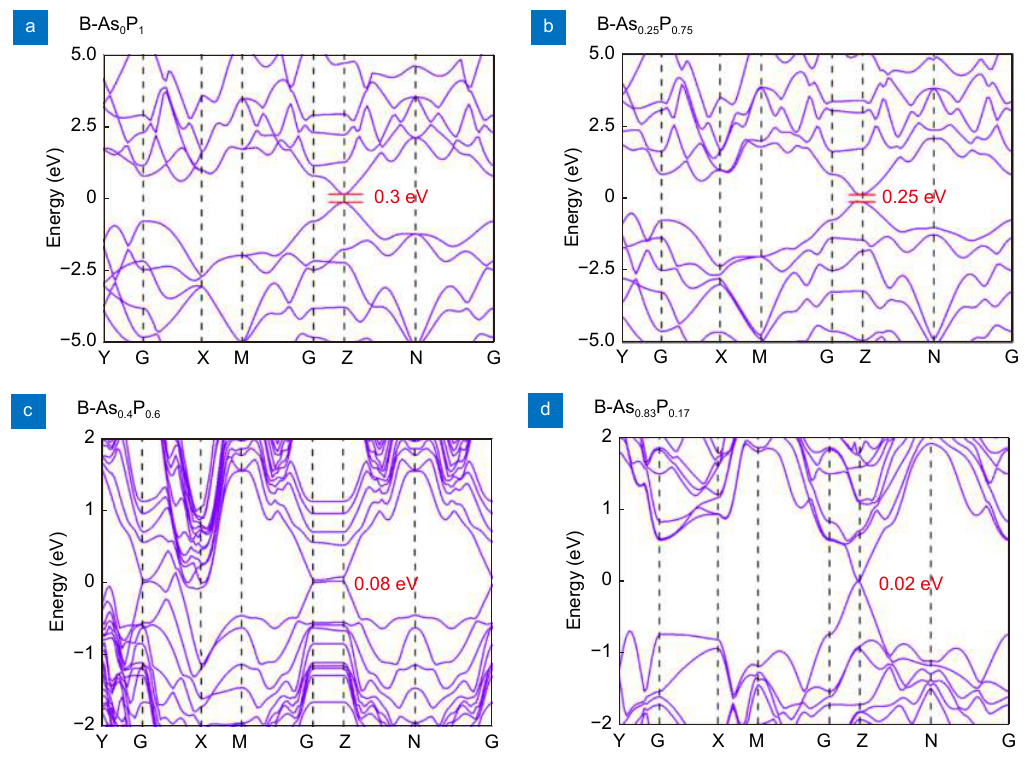
Fig. 2 | Band gap structures of the B-As x P 1- x with different value of “ x ” ( x = 0, 0.25, 0.4, and